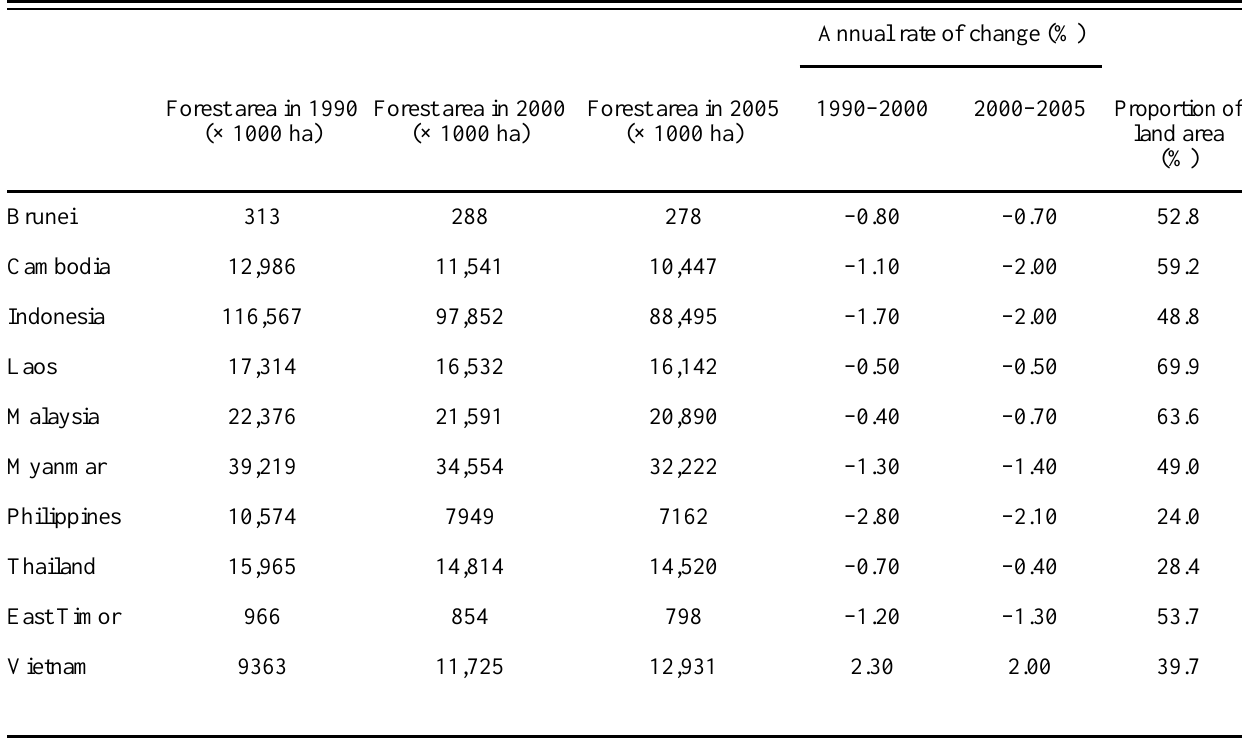
Table 1. Change in forest cover in Southeast Asia. Source: Food and Agriculture Organization